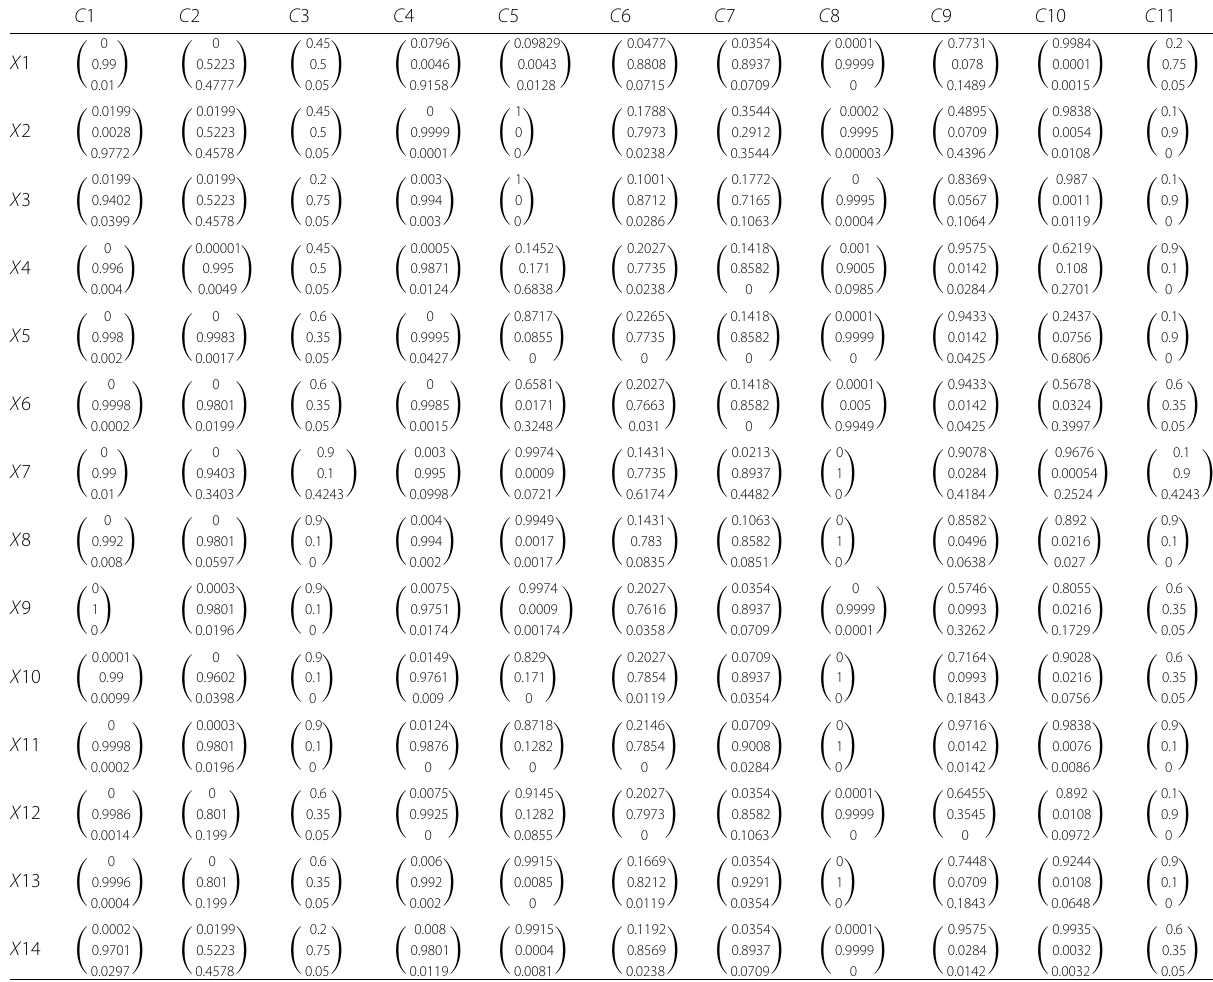
Table 6 The ratings of the alternatives for the evaluation